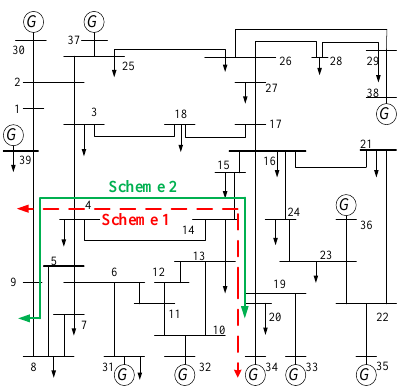
Figure 11. Optimal islanding surface (case 2). Table 5. Comparison of islanding surface searching algorithms. Islanding